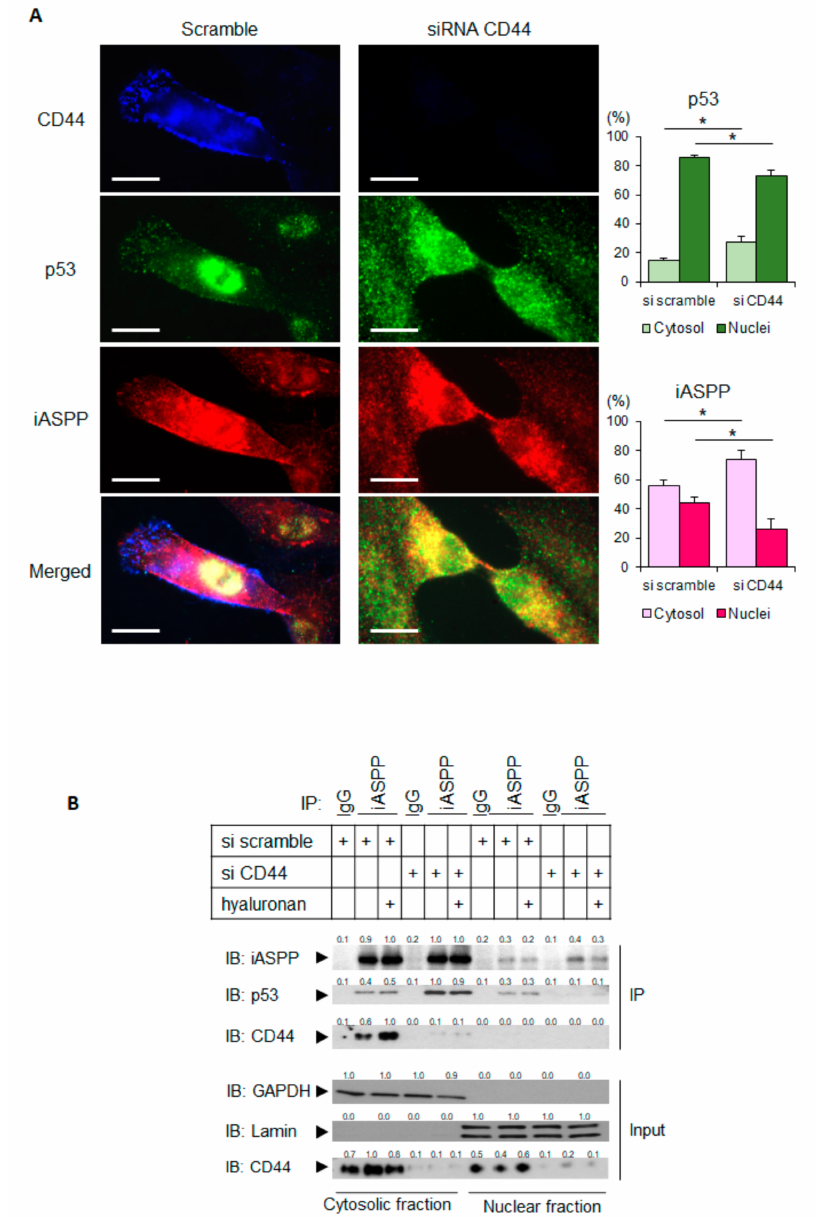
Figure 5. Depletion of CD44 promotes the translocation of p53 and iASPP to the cytoplasm. ( A ) hTERT-BJ cells treated with CD44 siRNA, or not, were stained for CD44 (blue), p53 (green), or iASPP (red). Images were taken using a Zeiss Axioplan 2 immunofluorescence microscope with a 63 × objective. By ImageJ software, the localizations of p53 and iASPP in cytosol and nuclei were measured and are shown in the panels to the right. Scale bars, 10 µ m. * p < 0.05, Student ´ s t -test. ( B ) Subcellular fractionation was performed on untreated or hyaluronan-stimulated hTERT-BJ cells transfected with siRNA for CD44 or scramble siRNA as control. Cell lysates were then immuno- precipitated with an iASPP antibody, followed by immunoblotting with iASPP, p53, and CD44 antibodies. The purity of the nuclear and cytoplasmic fractions was determined by immunoblotting for laminin and GAPDH, respectively. A representative experiment out of three independent exper- iments performed is shown. The data are plotted in bar graphs representing the mean ± SD of at least three independent experiments (* p < 0.05, Student’s t -test). The uncropped blots are shown in File